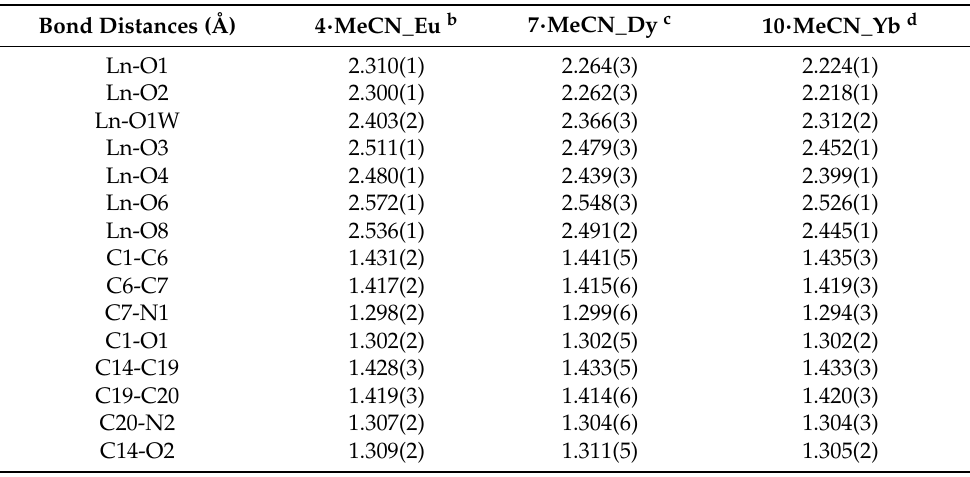
Table 1. Selected bond distances (Å) and angles (°) for complexes 4·MeCN_Eu, 7·MeCN_Dy, and 10 · MeCN_Yb a.